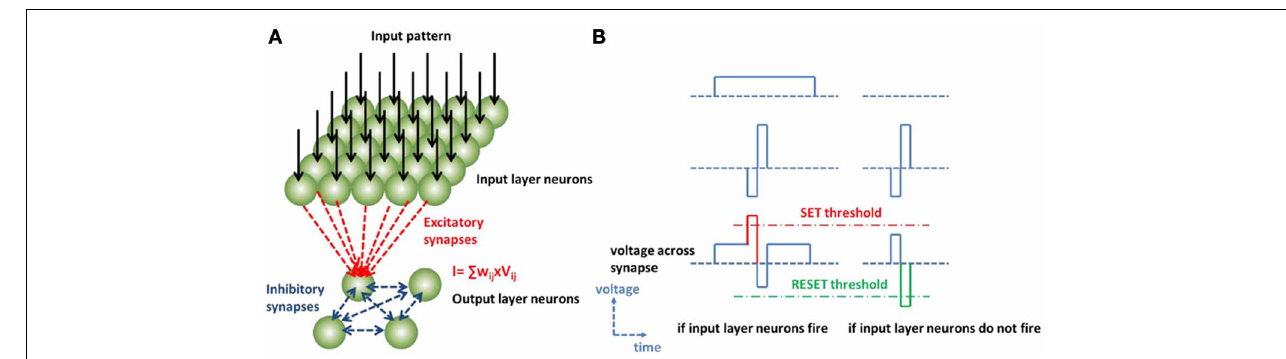
FIGURE 4 | (A) Neuromorphic system based on winner-take-all neural network. In the system-level simulation, 32 × 32 neurons in the input layer are connected with 2 × 2 neurons in the output layer through 4096 oxide based excitatory synaptic devices. Every neuron in the output layer also connects to one another through inhibitory synapses based on fixed resistors. (B) The spiking scheme for binary synapse with stochastic learning: the pre-synaptic forward spike from the input layer neuron is designed to be a long but small positive pulse (e.g., + 0.8V/500ns), the